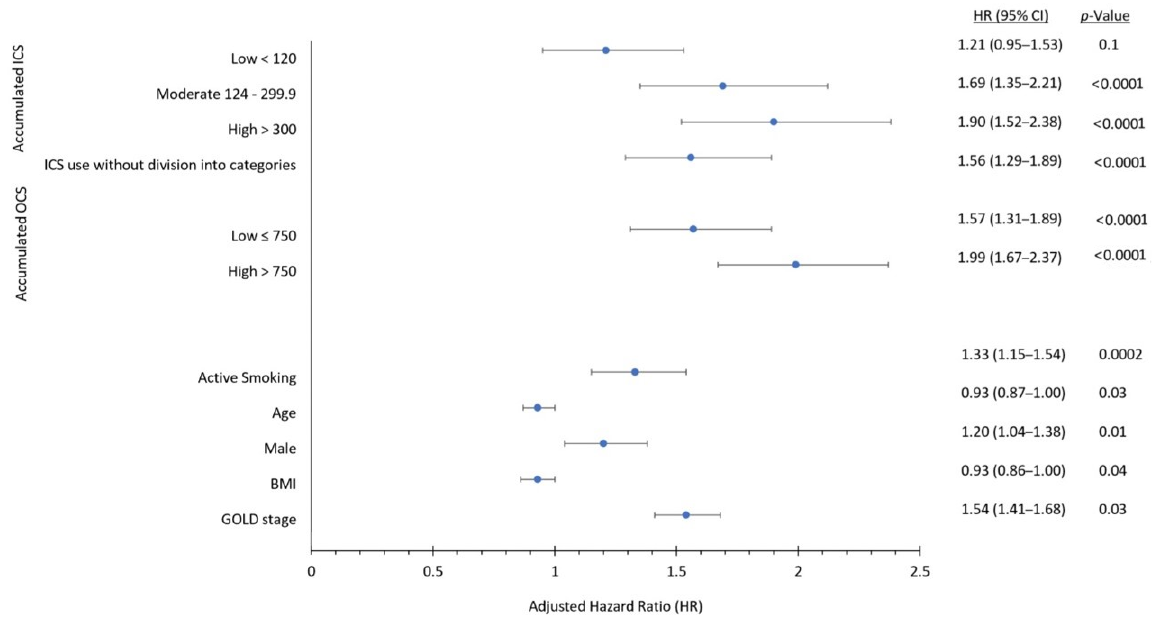
Figure 2. Forest plot of variables used in Cox proportional hazard regression model showing adjusted hazard ratios with their respective 95% confidence intervals . The variables include: accumulated ICS dose (low <120 mg, moderate 120–300 mg, high >300 mg; reference group; no ICS use), accumulated OCS dose (low ≤ 750 mg; high >750 mg; reference group; no OCS use), active smoking (reference group: non-active smoking), age (per group increase), sex (male; all female patients are included in analysis despite male sex being mentioned), BMI (body mass index; per group increase), and Global Initiative for Chronic Obstructive Lung Disease (GOLD) stage (per group increase).